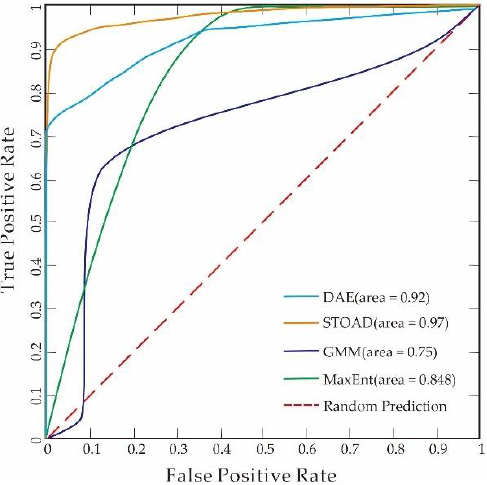
Figure 14. ROC curves of 4 methods, MaxEnt model, GMM, DAE model and STOAD model.